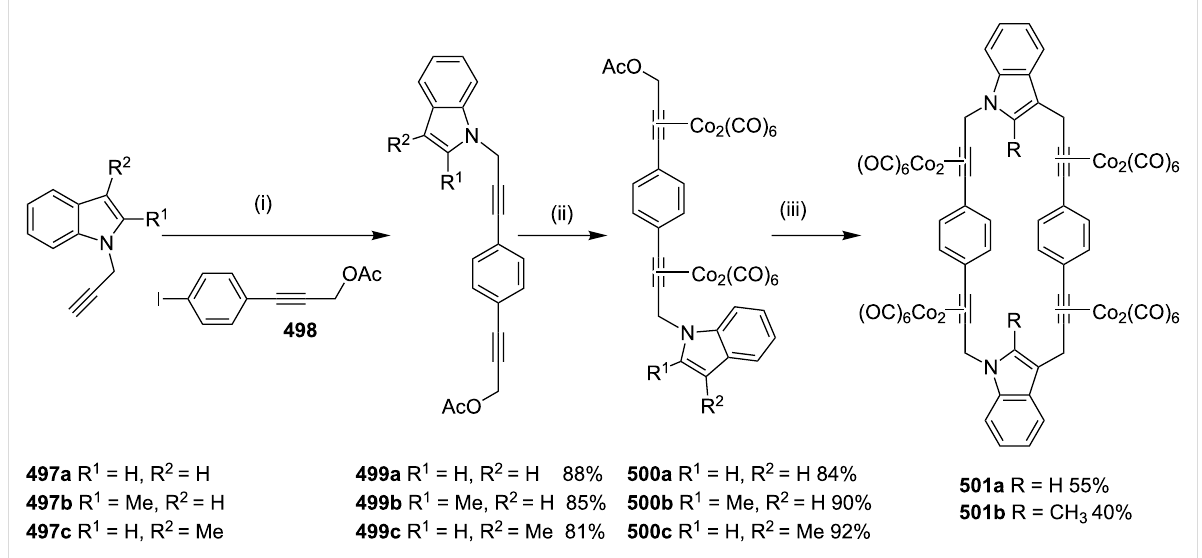
Scheme 92: Synthesis of indolophanetetraynes 501a , b using the Nicholas reaction as a key step. Reagents and conditions: (i) Pd(PPh 3 ) 4 , CuI,